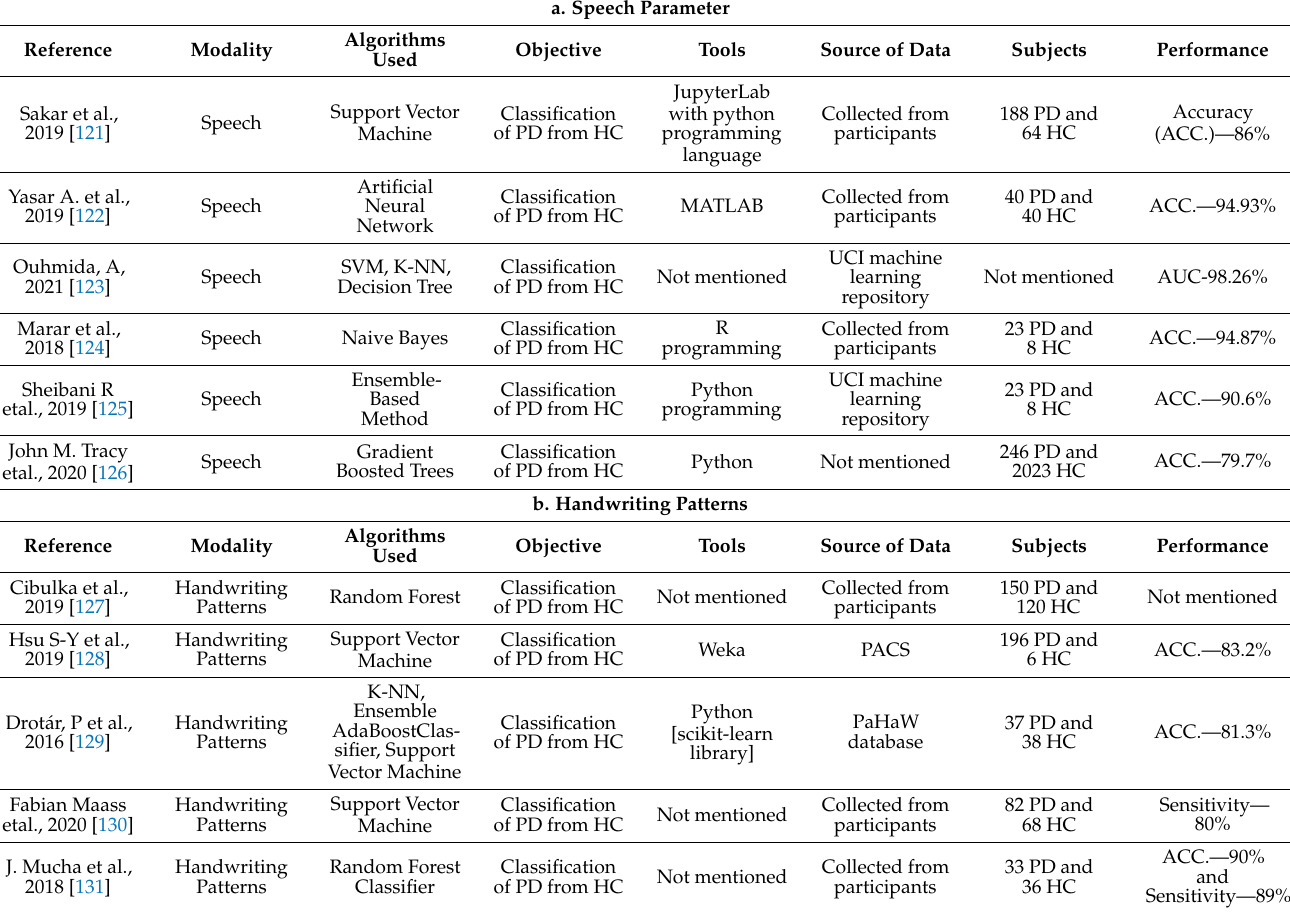
Table 3. Comparative research on Parkinson’s disease diagnosis using machine learning approaches (a. speech, b. handwriting patterns, and c. gait